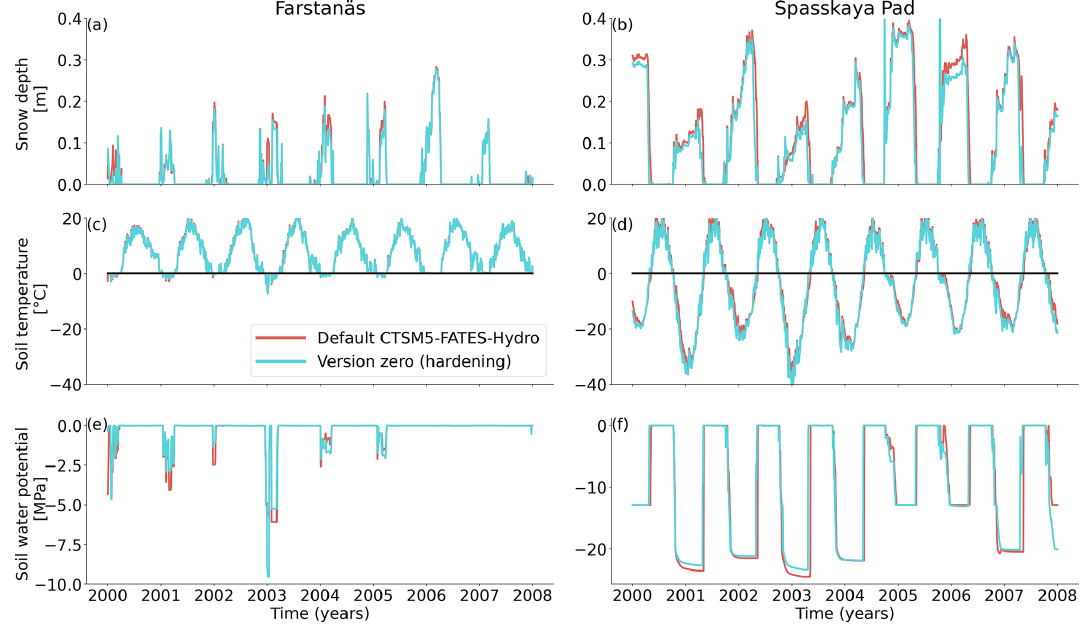
Figure 5. Soil conditions for needleleaf evergreen trees at the sites of ( a , c , and e ) Farstanäs and ( b , d , and f ) Spasskaya Pad during the period 2000–2008. (a,b) Transpiration, (c,d) root water uptake, and (e,f) stored plant water. The default simulation is shown in red, and the hardening simulation is shown in blue.